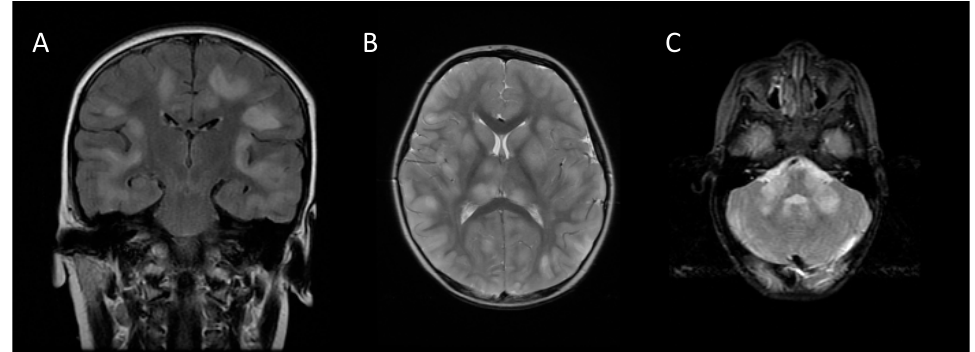
Figure 2. Typical magnetic resonance imaging features of ADEM: ( A ) coronal fluid-attenuated inversion recovery (FLAIR) image showing asymmetrical bilateral subcortical white matter abnormalities; ( B ) axial T2-weighted image depicting asymmetrical bilateral white and gray matter abnormalities; ( C ) axial T2-weighted image showing typical cerebellar peduncle lesions.